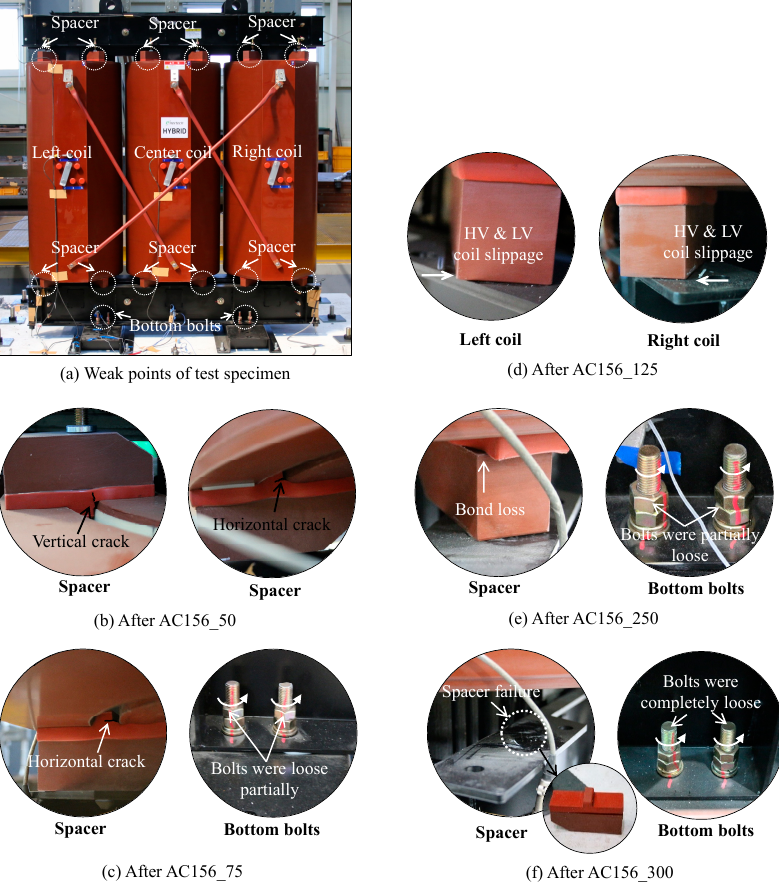
Figure 11. Damage observation after different shaking table tests: ( a ) Weak points of test specimen; ( b ) After AC156_50; ( c ) After AC156_75; ( d ) After AC156_125; ( e ) After AC156_250; ( f ) After AC156_300.